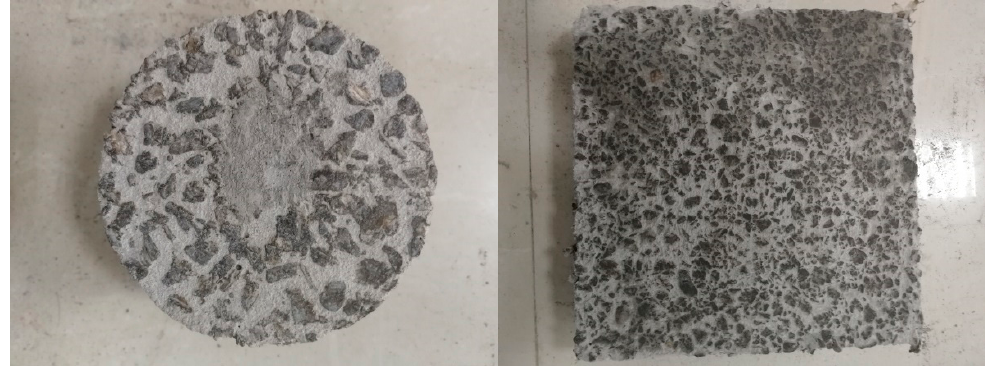
Figure 9. Samples after pouring water-retentive mortar (the left is Φ 101.6 mm × 63.5 mm Marshall sample, and the right is 300 mm × 300 mm × 50 mm rutting sample).